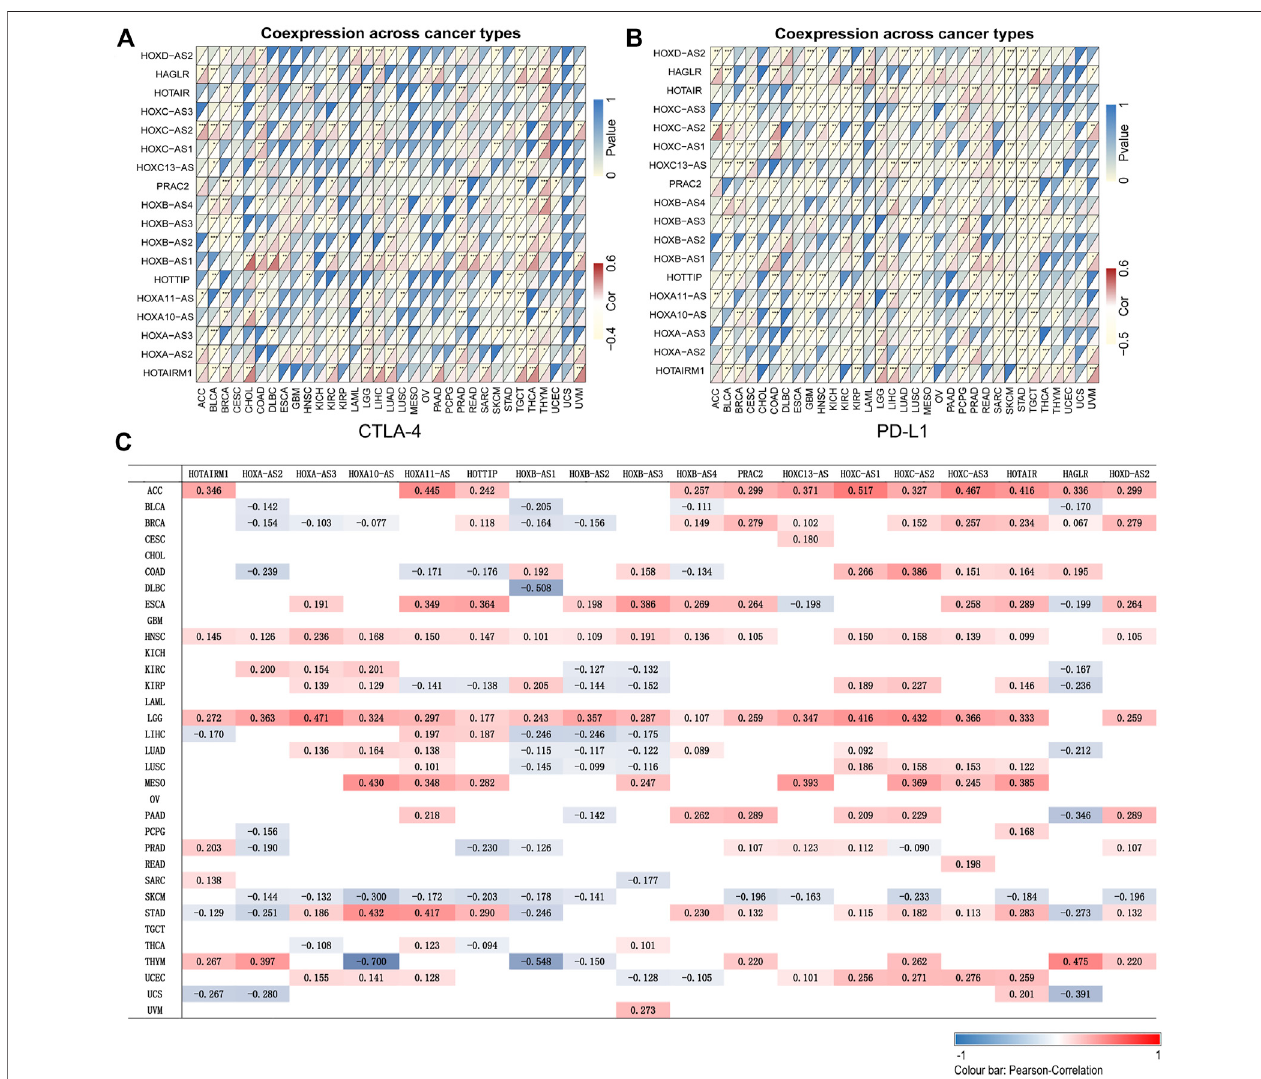
FIGURE 4 | Association of the homeobox antisense transcripts (HOXATs) with immune cell marker expression and tumor mutation burden (TMB). Heatmaps represent the association of the HOXATs expression with PD-L1 and CTLA4 in the pan-cancer (A, B) . For each pair, the top-right triangle represents the p -value, while the bottom-left triangle represents the correlation coef fi cient. * p < 0.05, ** p < 0.01, *** p < 0.001. Heat map showing the correlation between the HOXAT expression and TMB (C) . The numbers on the heatmap represent the Spearman correlation values, where red and blue represent positive and negative correlations, respectively. * p < 0.05, ** p < 0.01, *** p <